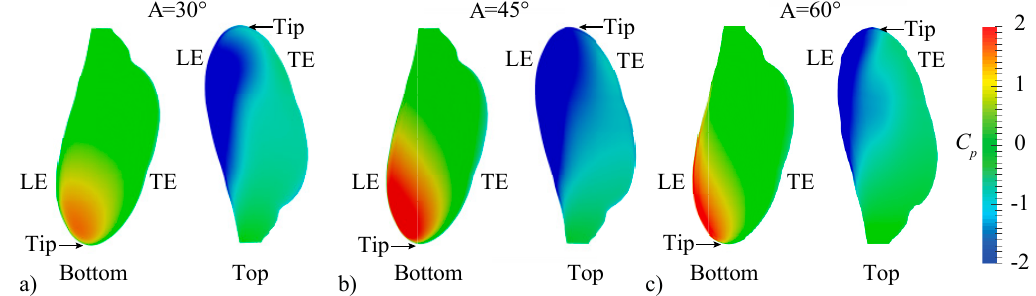
Figure 7. Contour plots of the NSe coefficient of pressure on the top and bottom of the wing at the middle of the forward stroke ( t / T = 0.25) for Δ τ r = 0.3 and x pa = 0.5; ( a ) A = 30°, ( b ) A = 45°, and ( c ) A = 60°.